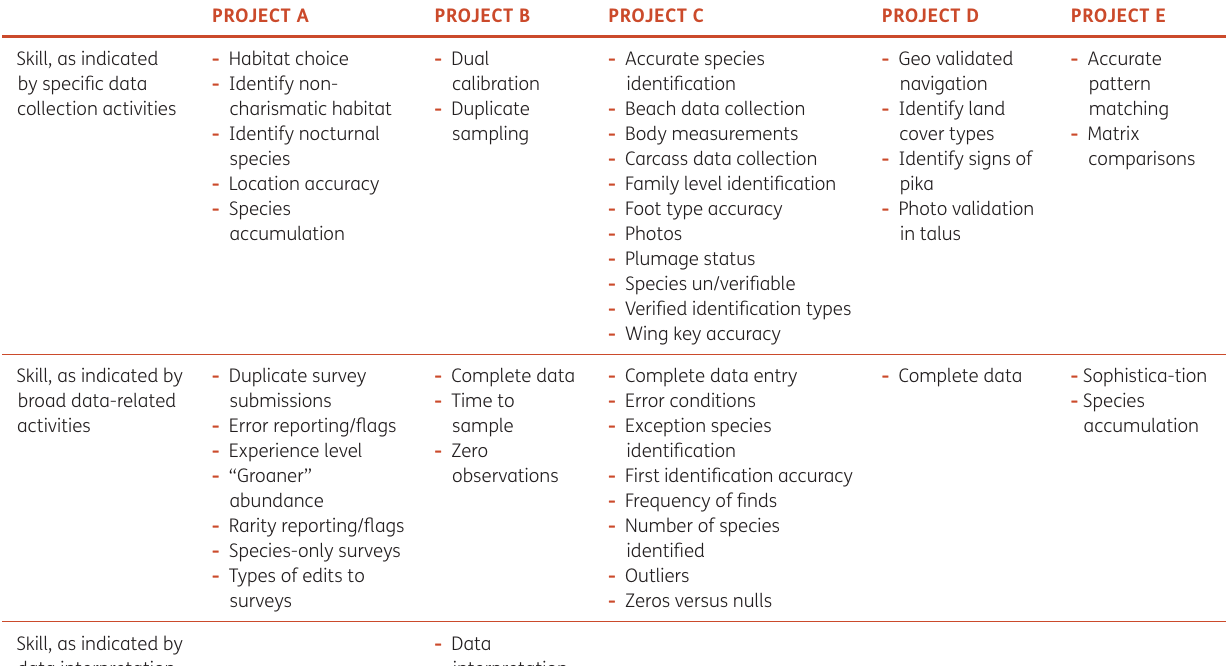
Table 2 Skills Skills in data records, by